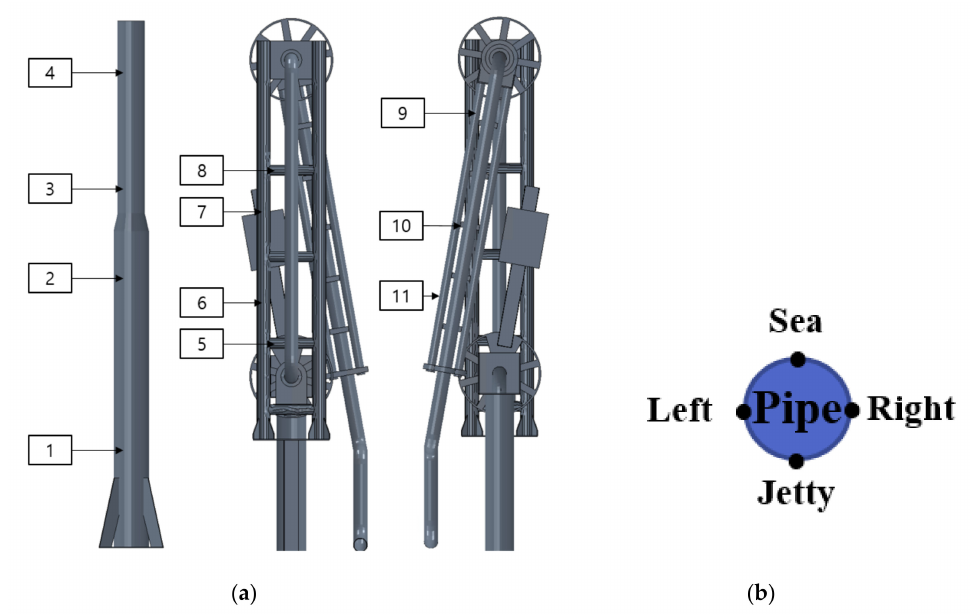
Figure 5. ( a ) Sample points of the NDT used to define the deterioration function of structure over time and ( b ) thickness-inspection positions of each section in the